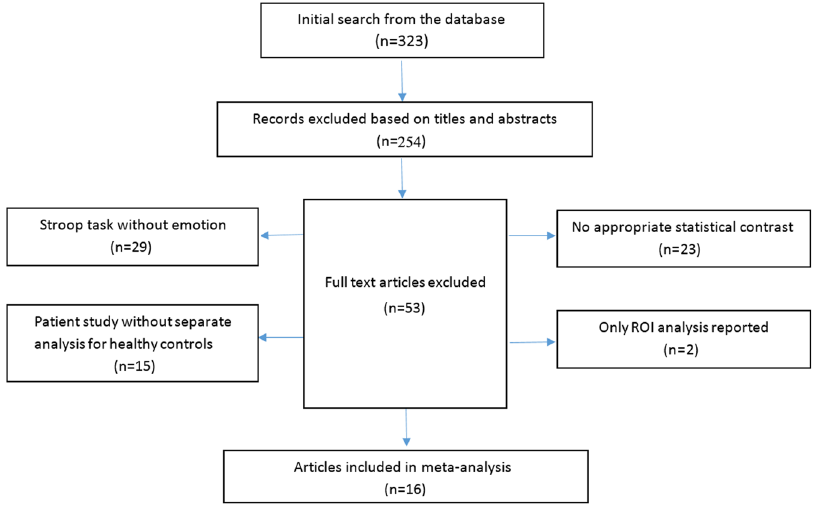
Figure 3. Flowchart of the study selection